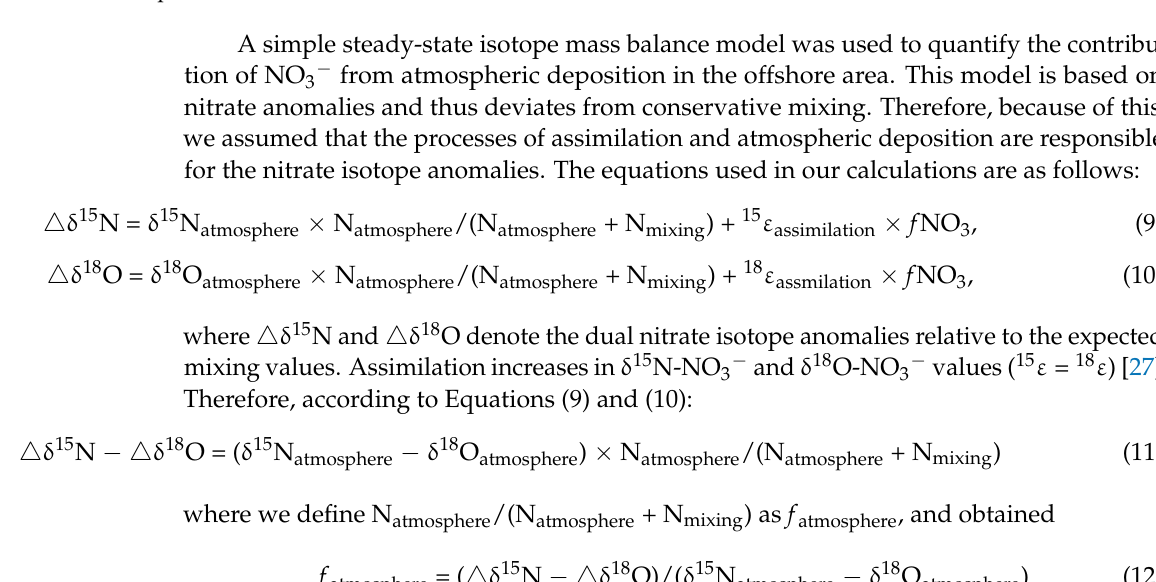
Figure 8. ( a ) NO 3 − concentrations as a function of salinity in the offshore area. The solid line is the mixing line calculated for endmembers defined by stations BH01 and BH20; ( b ) the relationship between δ 15 N-NO 3 − and δ 18 O-NO 3 − values in the offshore area. The slope of the line = 1.